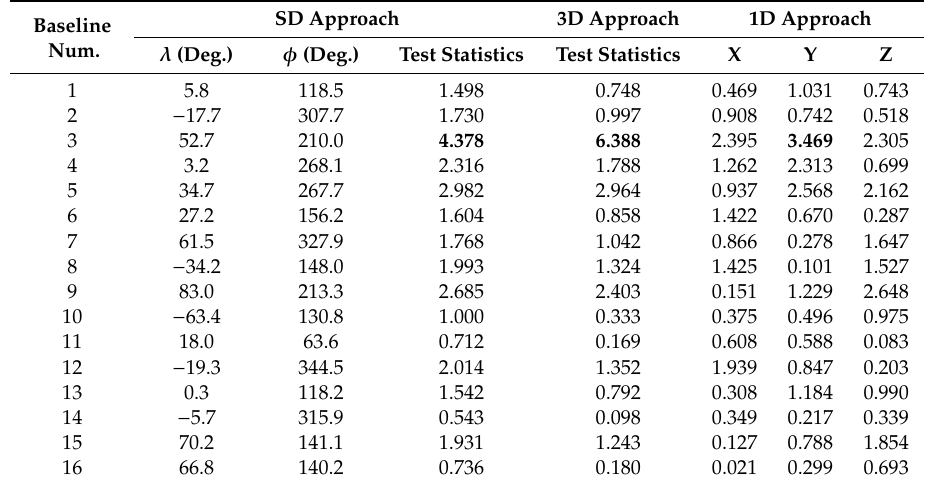
Table 1. Test Statistics of baseline observations by Specific Direction-based (SD), 3D, and 1D approach.